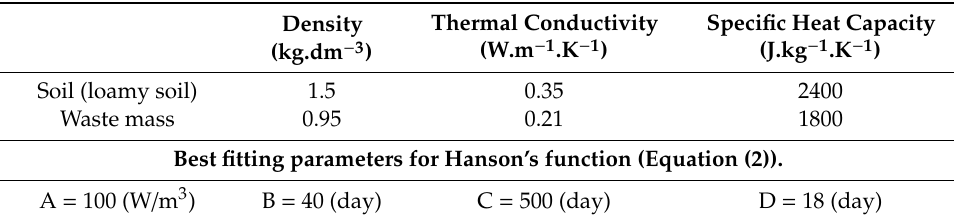
Table 2. Thermal properties for best fitting modelling.